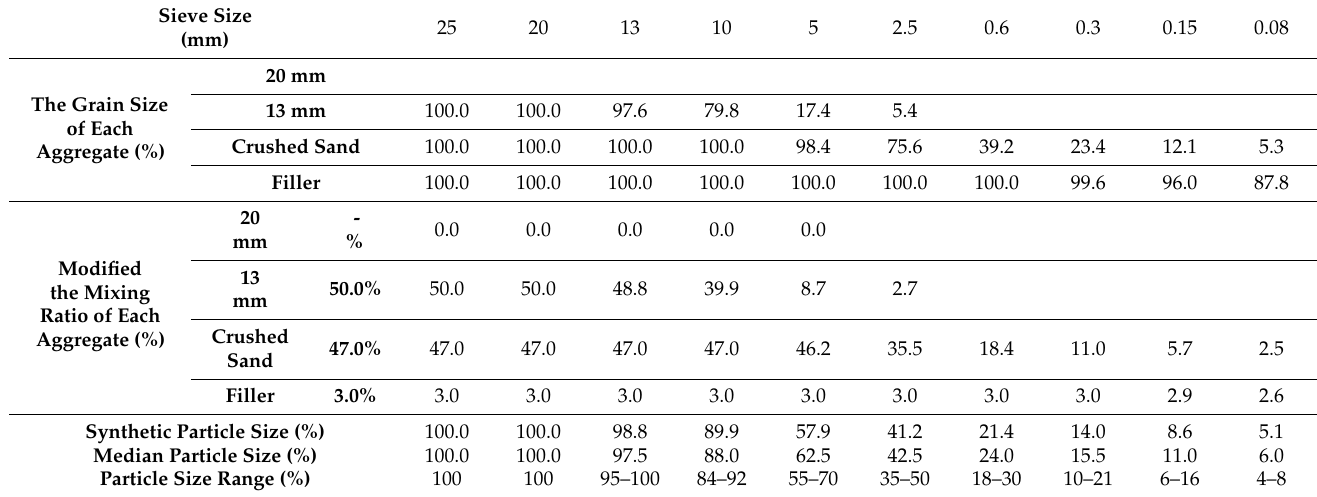
Table 3. Aggregate content by sieve size.